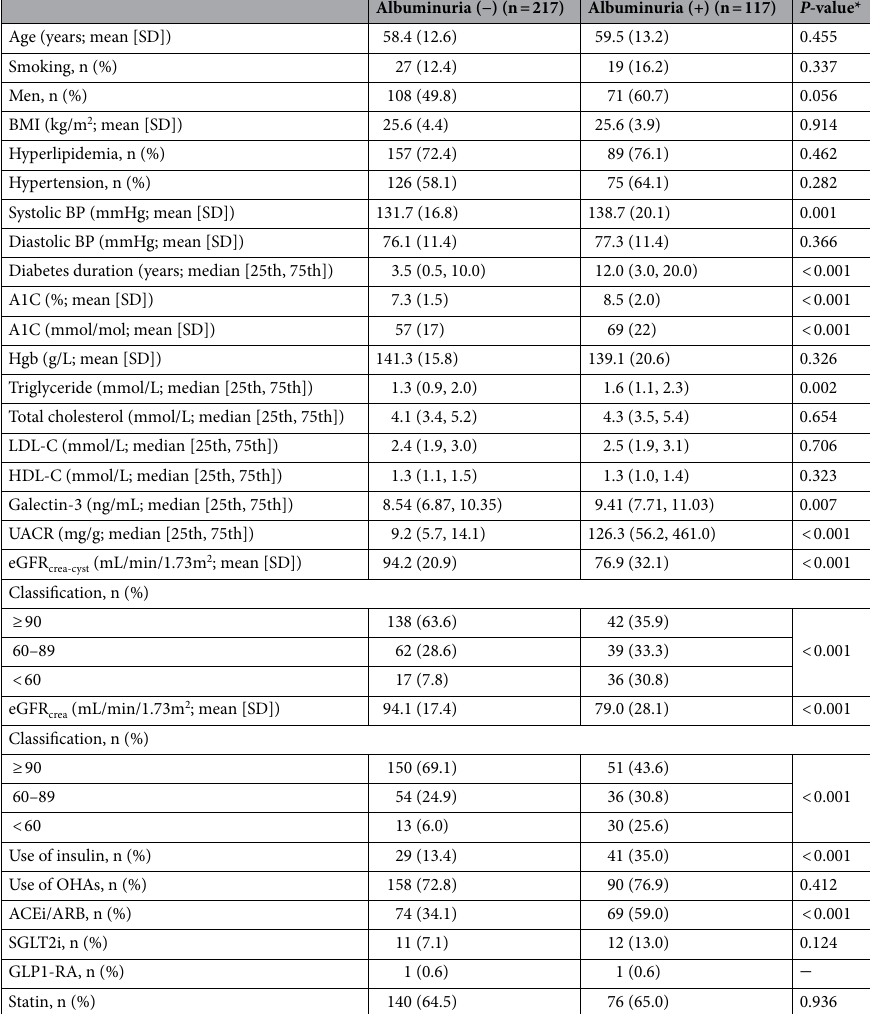
ARB angiotensin II receptor blocker, BMI body mass index, BP blood pressure, eGFR estimated glomerular filtration rate, GLP1-RA glucagon-like peptide-1 receptor agonist, Hgb hemoglobin, HDL-C high-density lipoprotein cholesterol, LDL-C low-density lipoprotein cholesterol, OHA oral hypoglycemic agent, SD standard deviation, SGLT2i sodium-glucose cotransporter 2 inhibitor, T2DM type 2 diabetes mellitus, UACR urinary albumin-to-creatinine ratio. *Student’s t-test and the Mann–Whitney U test for parametric and nonparametric continuous variables (diabetes duration, triglyceride, total cholesterol, LDL-C, HDL-C, Galectin-3, and UACR); the chi-squared test for categorical